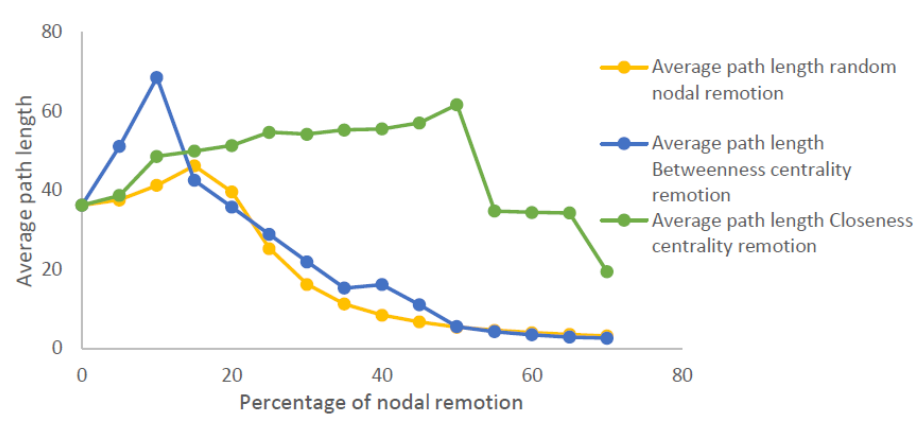
Figure 12. Average path length affectation in different scenarios of random nodal remotion.